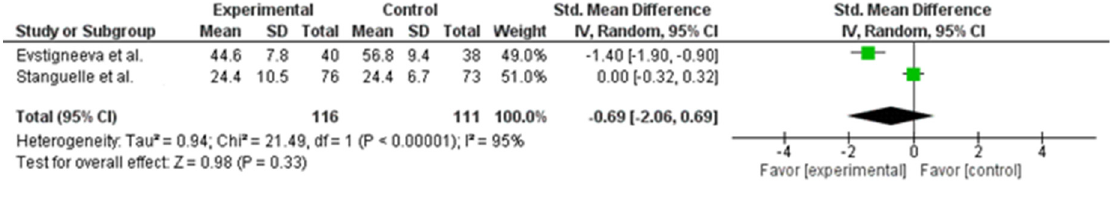
Figure 2. Forest plot (QUALEFFO-41)